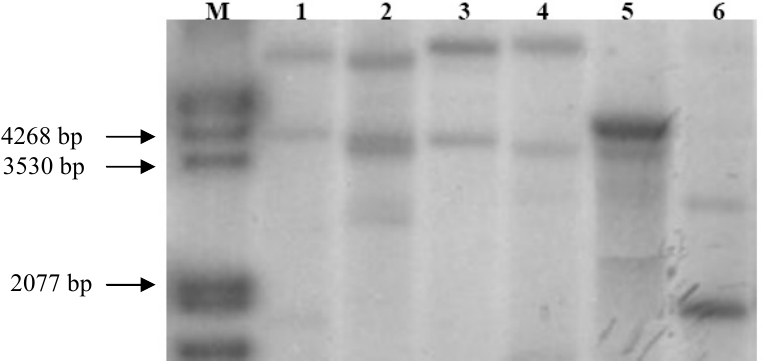
Figure 1 . Genomic DNA digested with EcoR I, hybridized with Mal d 3-DIG labeled probe, M) molecular weight marker III, 1) apple, 2) plum, 3) cherry, 4) strawberry, 5) raspberry, 6)